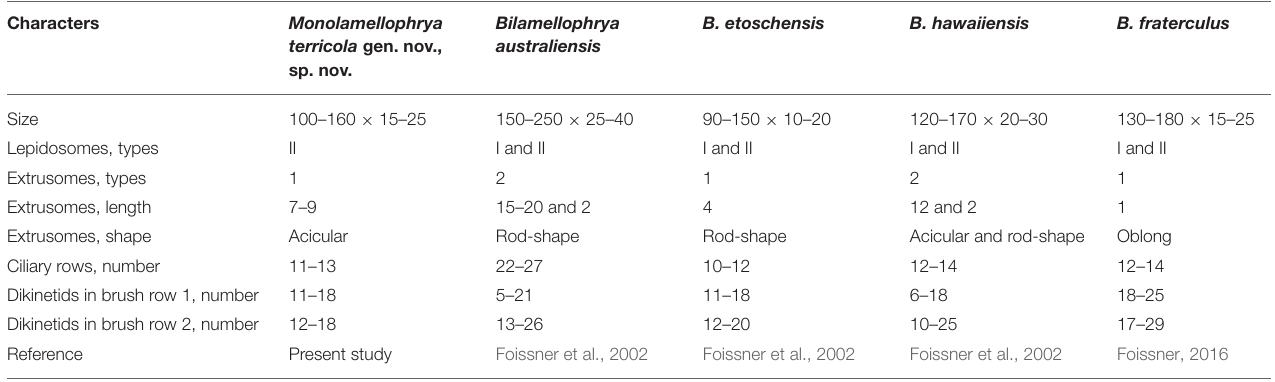
TABLE 3 | Comparison between Monolamellophrya terricola gen. nov., sp. nov. and similar